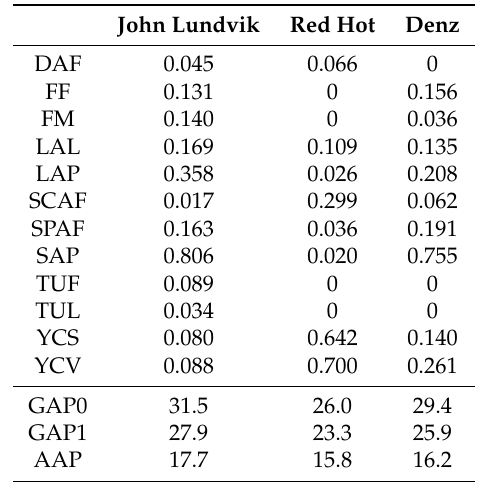
Table 7. Popularity scores as expressed by all individual metrics and aggregation methods GAP0, GAP1, and AAP for three artists of our dataset. The following abbreviations are used: DAF, Deezer Artist Fans; FF, Facebook Fans; FM, Facebook Mentions; LAL, Last.fm Artist Listeners; LAP, Last.fm Artist Plays; SCAF, Soundcloud Artist Followers; SPAF, Spotify Artist Followers; SAP, Spotify Artist Popularity; TUF, Twitter User Followers; TUL, Twitter User Listed; YCS, YouTube Channel Subscribers; YCV, YouTube Channel